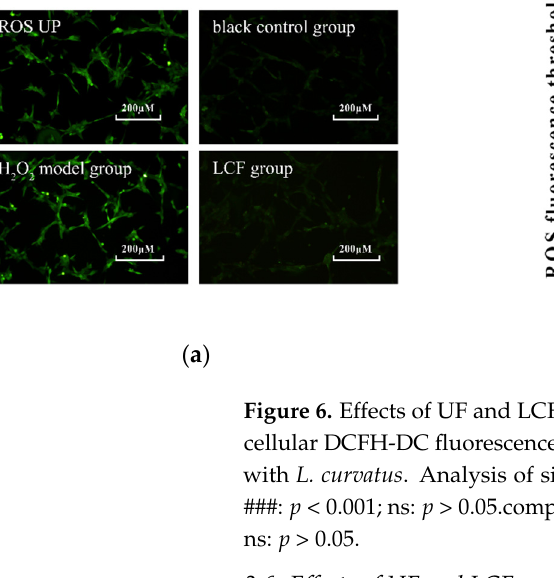
Figure 7. Effects of UF and LCF on cellular antioxidant capacity. UF: unfermentation; LCF: single microbial fermentation with L. curvatus . Analysis of significant differences between each group and H 2 O 2 model group, #: p < 0.05; ##: p < 0.01; ###: p < 0.001. comparison of each group between UF and LCF, ***: p < 0.001; ns: p > 0.05.